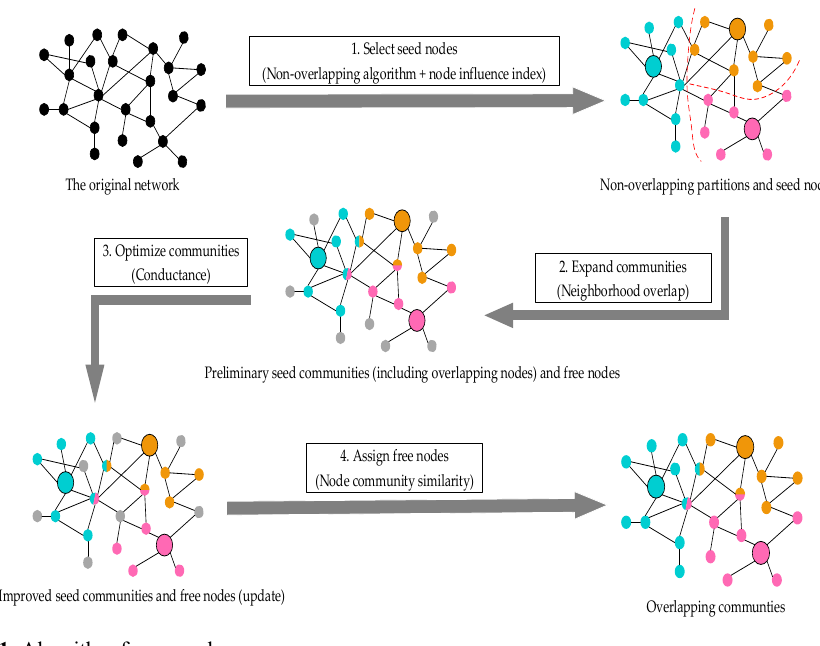
Fig. 1. Algorithm